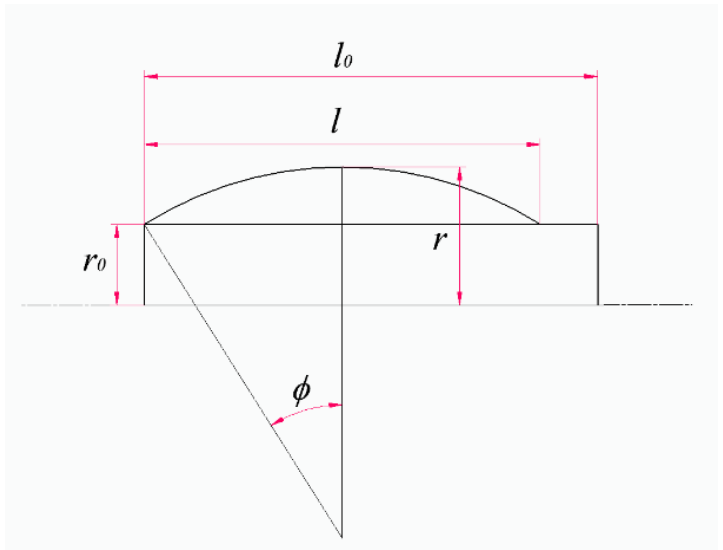
Figure 2. Geometric and functional parameters of a sector of the muscle.